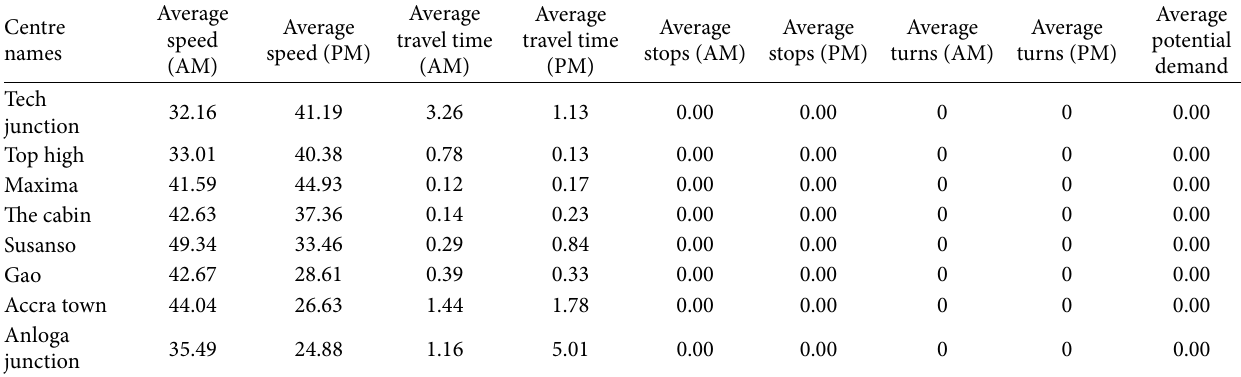
Table 2: Travel survey data for private cars on mondays in all the weeks.